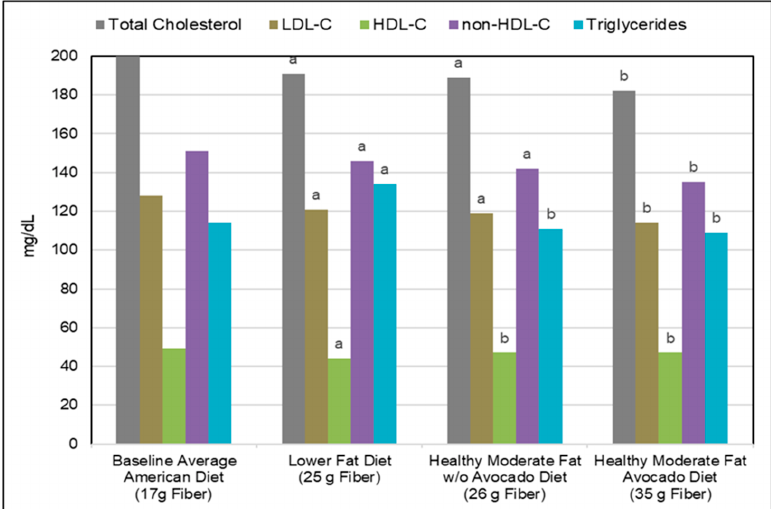
Figure 10. Effect of fiber and fat on total and LDL-cholesterol in a crossover Randomized Controlled Trial (RCT) of 45 overweight or obese adults over 5 weeks (based on 2100 kcal/diets; total fat 34% of energy for all diets except 24% for the low-fat diet; protein approx. 16% of energy for all diets; saturated fat energy 13% for the American diet, 7% for the low-fat diet and 6% for the two moderate fat diets with healthy vegetable oil vs. 1 avocado. Values with different superscript letters (a and b) are significantly different ( p < 0.05) [169].